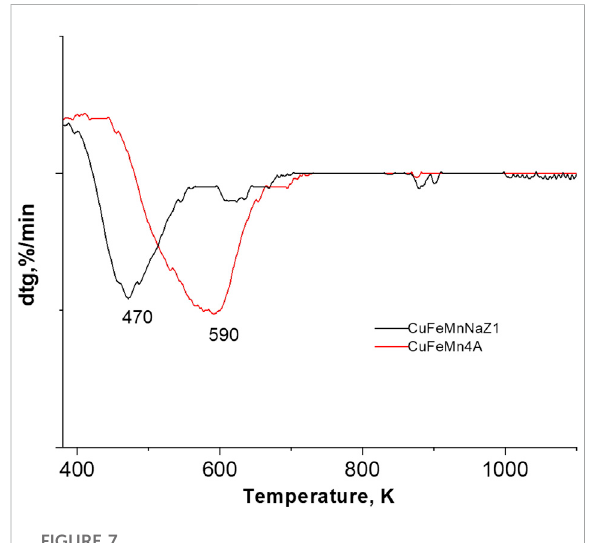
FIGURE 7 TPR pro fi les of the calc-CuFeMn-NaZ and calc-CuFeMn-4A